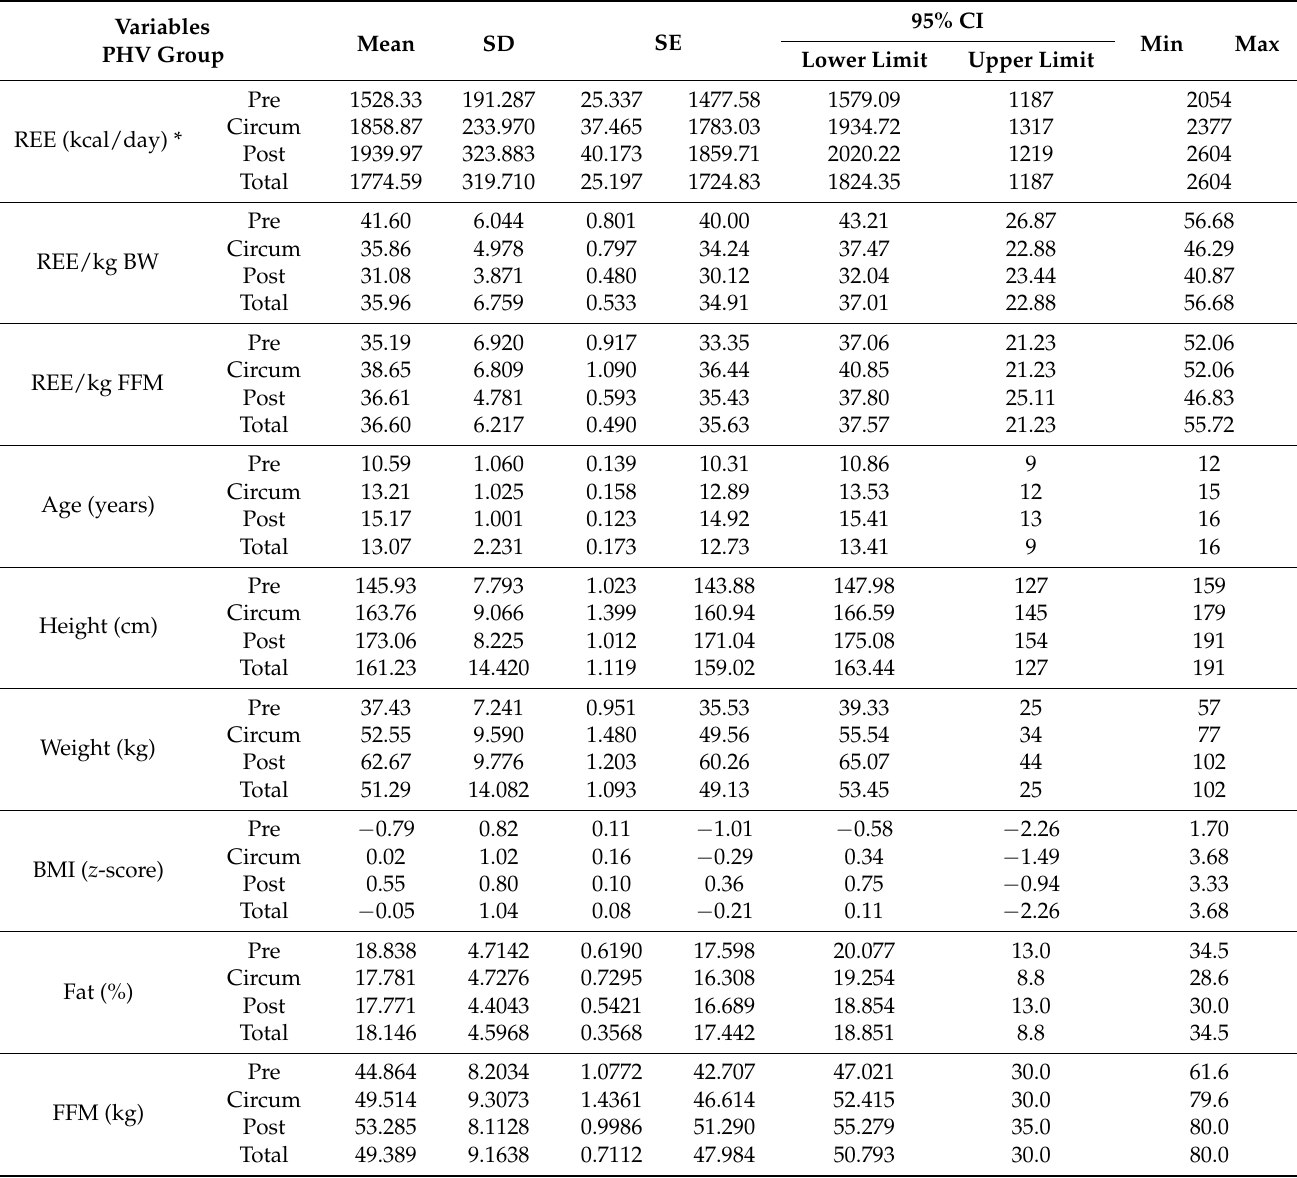
Table 1. Descriptive statistics for the individual peak height velocity (PHV) groups for the selected variables.